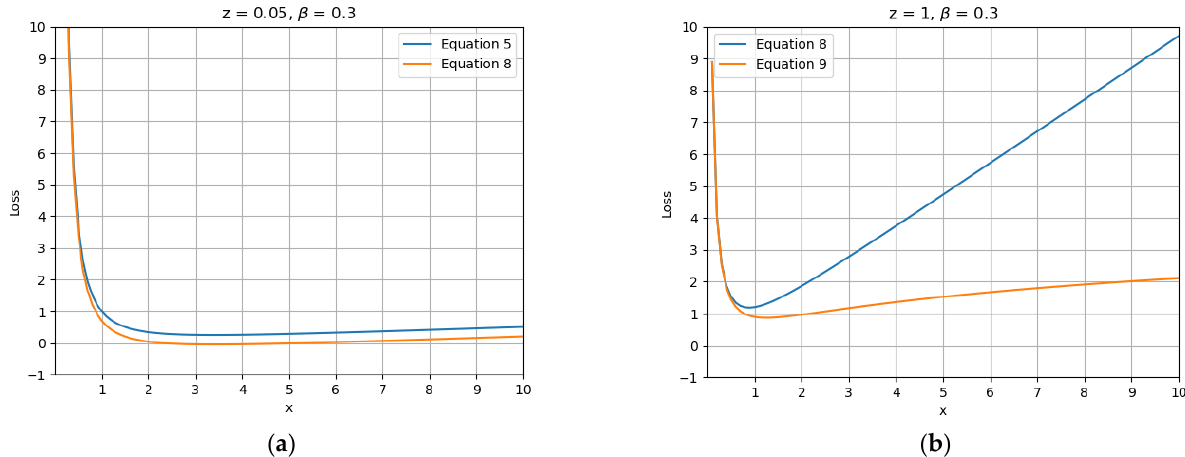
Figure 3. Comparison of Equations (5), (8), and (9) for z , which is the absolute value of the difference in length of the two normalized embedding vectors, and β , which is the specific constant. ( a ) Equations (5) and (8) for z = 0.05, β = 0.3.; ( b ) Equations (8) and (9) for z = 1, β = 0.3.